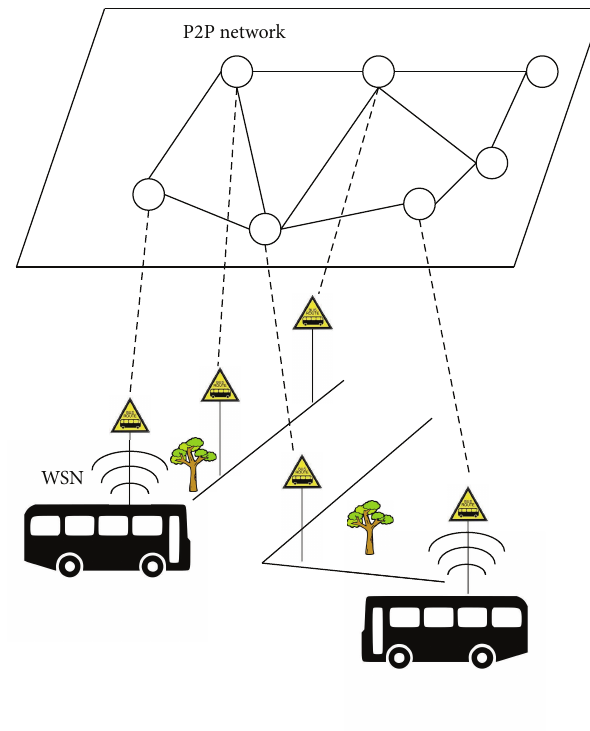
Figure 1: Illustration of the system platform.